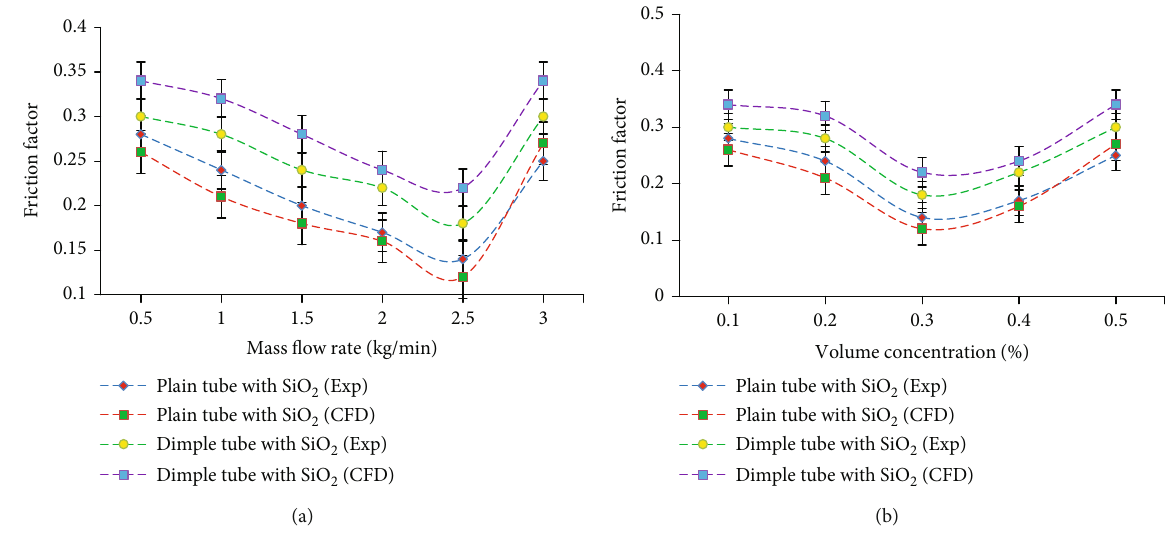
Figure 11: (a) Mass fl ow rate vs. friction factor. (b) Volume concentration vs. friction